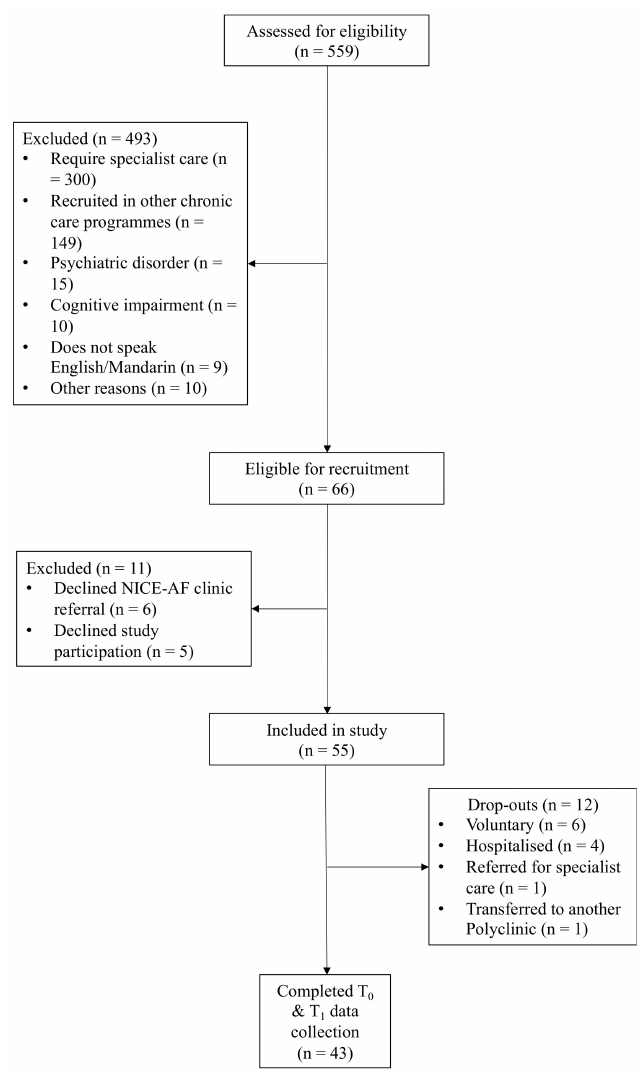
Figure 5. Recruitment